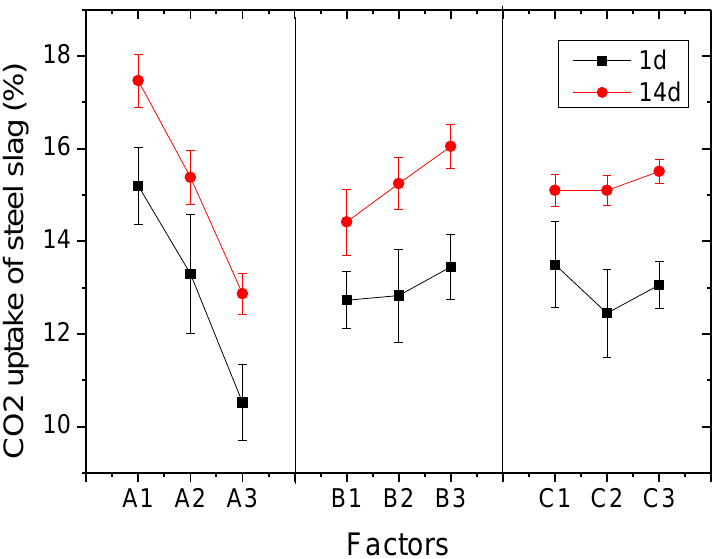
Figure 6. The effect curve of three factors on 1 d and 14 d CO 2 uptake of steel slag. The 14-day CO 2 uptake of steel slag values ranged from 12.03% to 18.85%. The best values for the three factors were as follows: the w/s value was 1:5 (A1), G/SS was